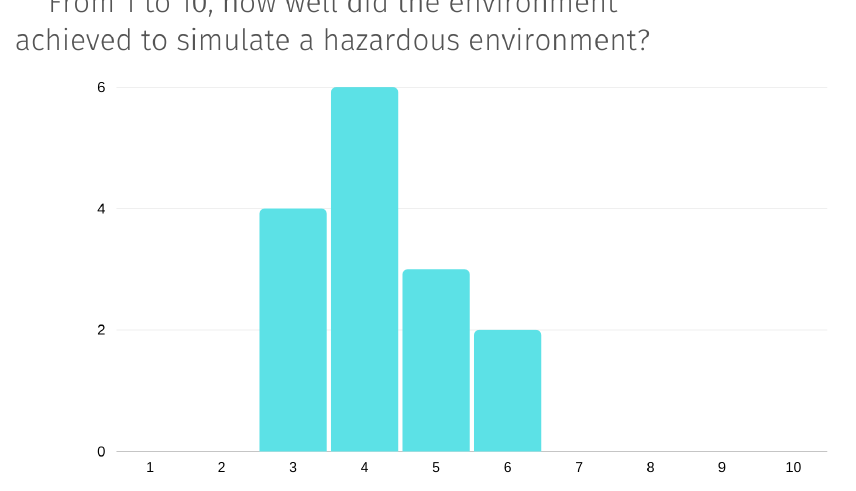
Figure 7. Question about the